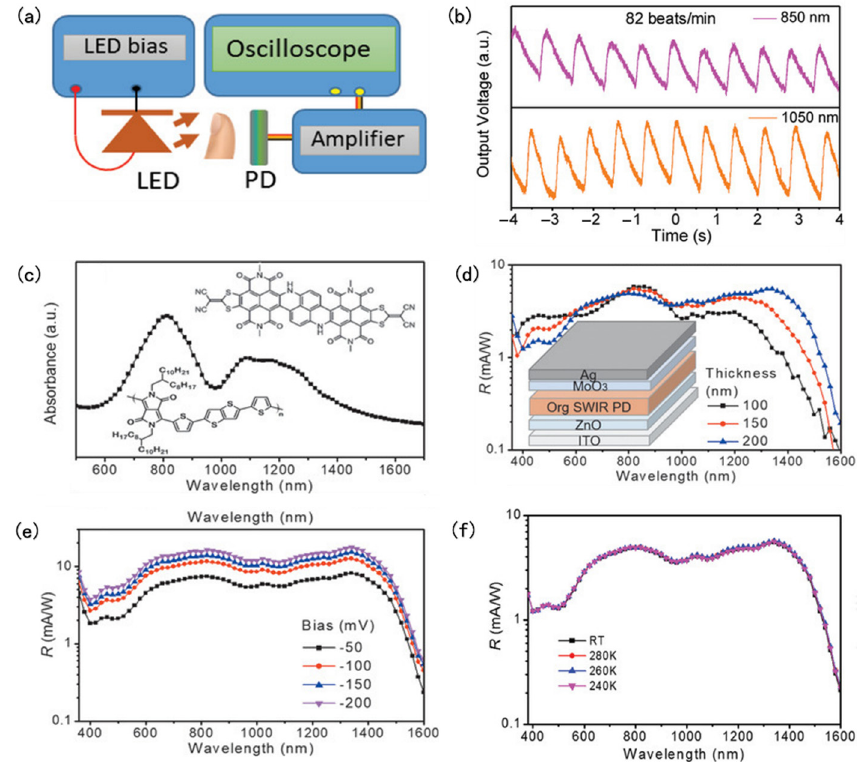
Figure 4. Structure and performance characterization of all-organic SWIR-to-visible upconversion devices. ( a ) A schematic of the measurement setup. ( b ) The heartbeat waveform measured by the device using NIR (850 nm) and SWIR (1050 nm) light illuminations, this picture shows a heart rate of 82 beats min − 1 . ( c ) The absorption spectrum of the DPP–DTT: SWIR dye blend layer deposited on glass. The insets in ( c ) are molecular structures of the DPP–DTT polymer and the SWIR dye. ( d ) R( λ ) of the organic SWIR PDs, with different BHJ layer thicknesses, as a function of the wavelength. The inset in ( d ) is the structure of this organic SWIR PD. ( e ) R( λ ) of an organic SWIR PD as a function of the wavelength with a 200 nm thick BHJ layer operated under different reverse biases. ( f ) R( λ ) of an organic SWIR PD, with a 200 nm thick BHJ, measured at different temperatures [42]. Copyright 2020, Advanced